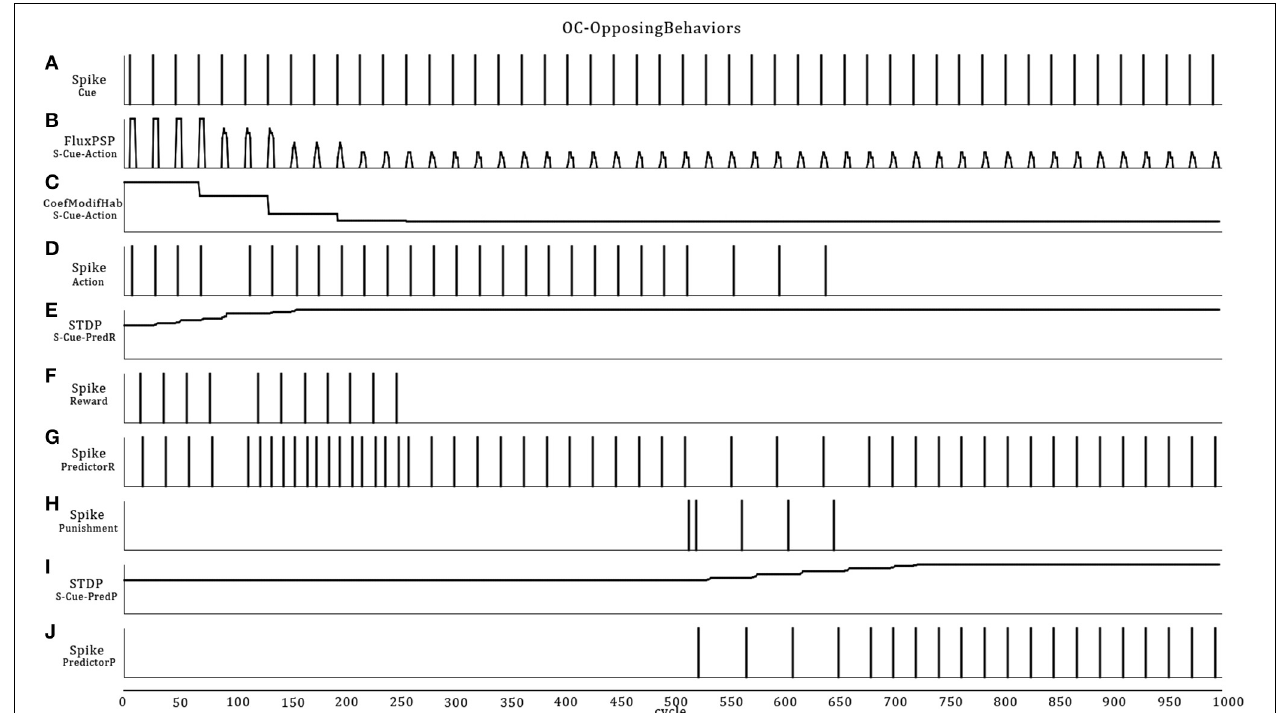
FIGURE 7 | Extension of the OC scenario A (Figures 4, 5) by following the response with a punishment. The result is that the robot first learns to emit sound to get a rewarding light and then, ceases emission to avoid a punishing heat wave. Thus, Cue regularly catches vibes from the virtual world (A) . The synaptic link between Cue and Action conveys PSPs with decreasing strength in time (B) from the habituation rule (C) . Then, Action only spikes (D) when the temporal summation of all incoming PSPs is strong enough. Because Cue also emits to PredictorR, PSPs are produced in time but with